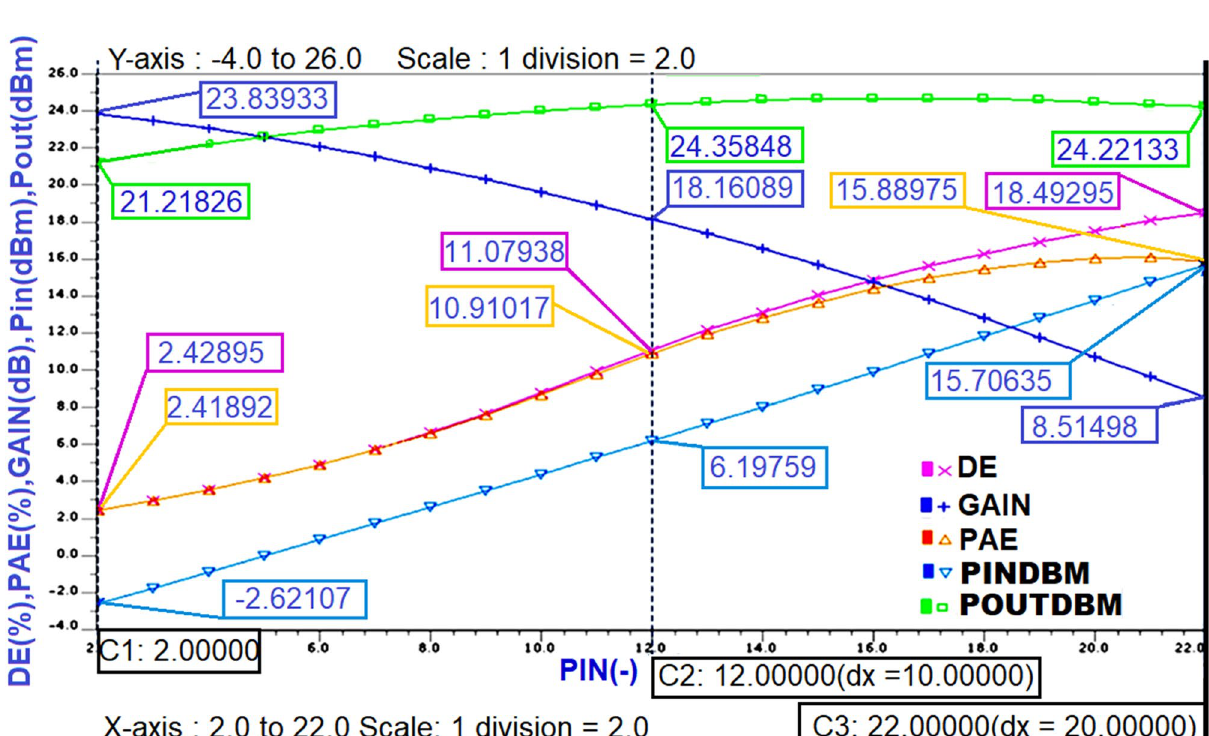
Figure 13. The performance parameters of Class-J PA with RF input at 850